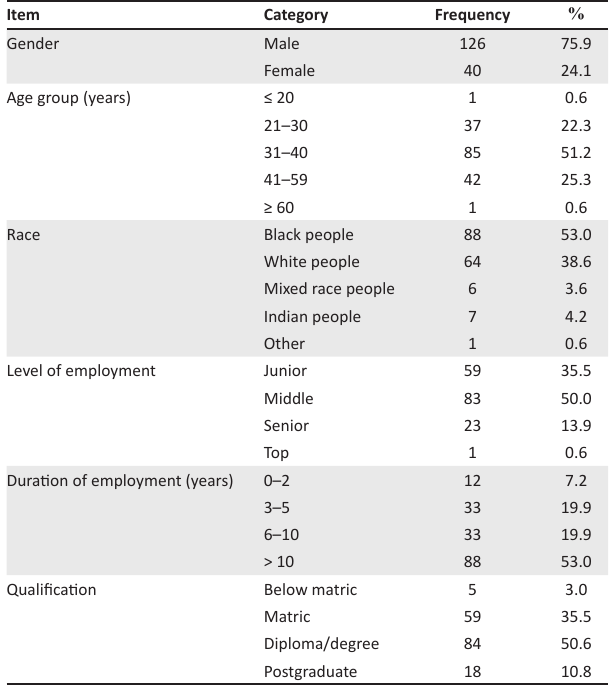
TABLE 1: Biographical profile of the